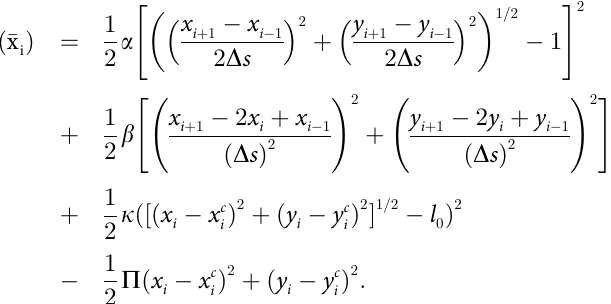
S1 Fig. Cell boundary ordering, orientation, smoothing and parameterization. The tech- niques used to order, orient and smooth the boundary of cells after edge detection are shown. A) A scatter plot of boundary points with the shaded region denoting the nearest neighbor- hood of the current boundary point (shown in red) obtained using the Manhattan distance metric. The next ordered point (shown in green) is subsequently obtained as the closest point (in Euclidean distance) to the current point. B) The turning angles α and α for the triplicate 1 2 p 1 , p 2 , p 3 are shown. C) The edge detected from a portion of the cell shows artificial sharp changes in curvature which are resolved using Gaussian smoothing. D) Equally spaced points are generated from a B-spline representation of the ordered, oriented boundary points. S2 Fig. A flowchart showing the methodology for detecting blebs from a time-lapse of dis- cretized cell boundaries. S3 Fig. Final output of the bleb detection algorithm for selected blebs. Figure shows results of all four geometric tests used to validate the presence of a bleb as well the major geometric markers used. Blue outline indicates the cell boundary before the bleb forms, the orange line indicates the cell boundary after the bleb forms. Blue dots indicate the bleb shoulder